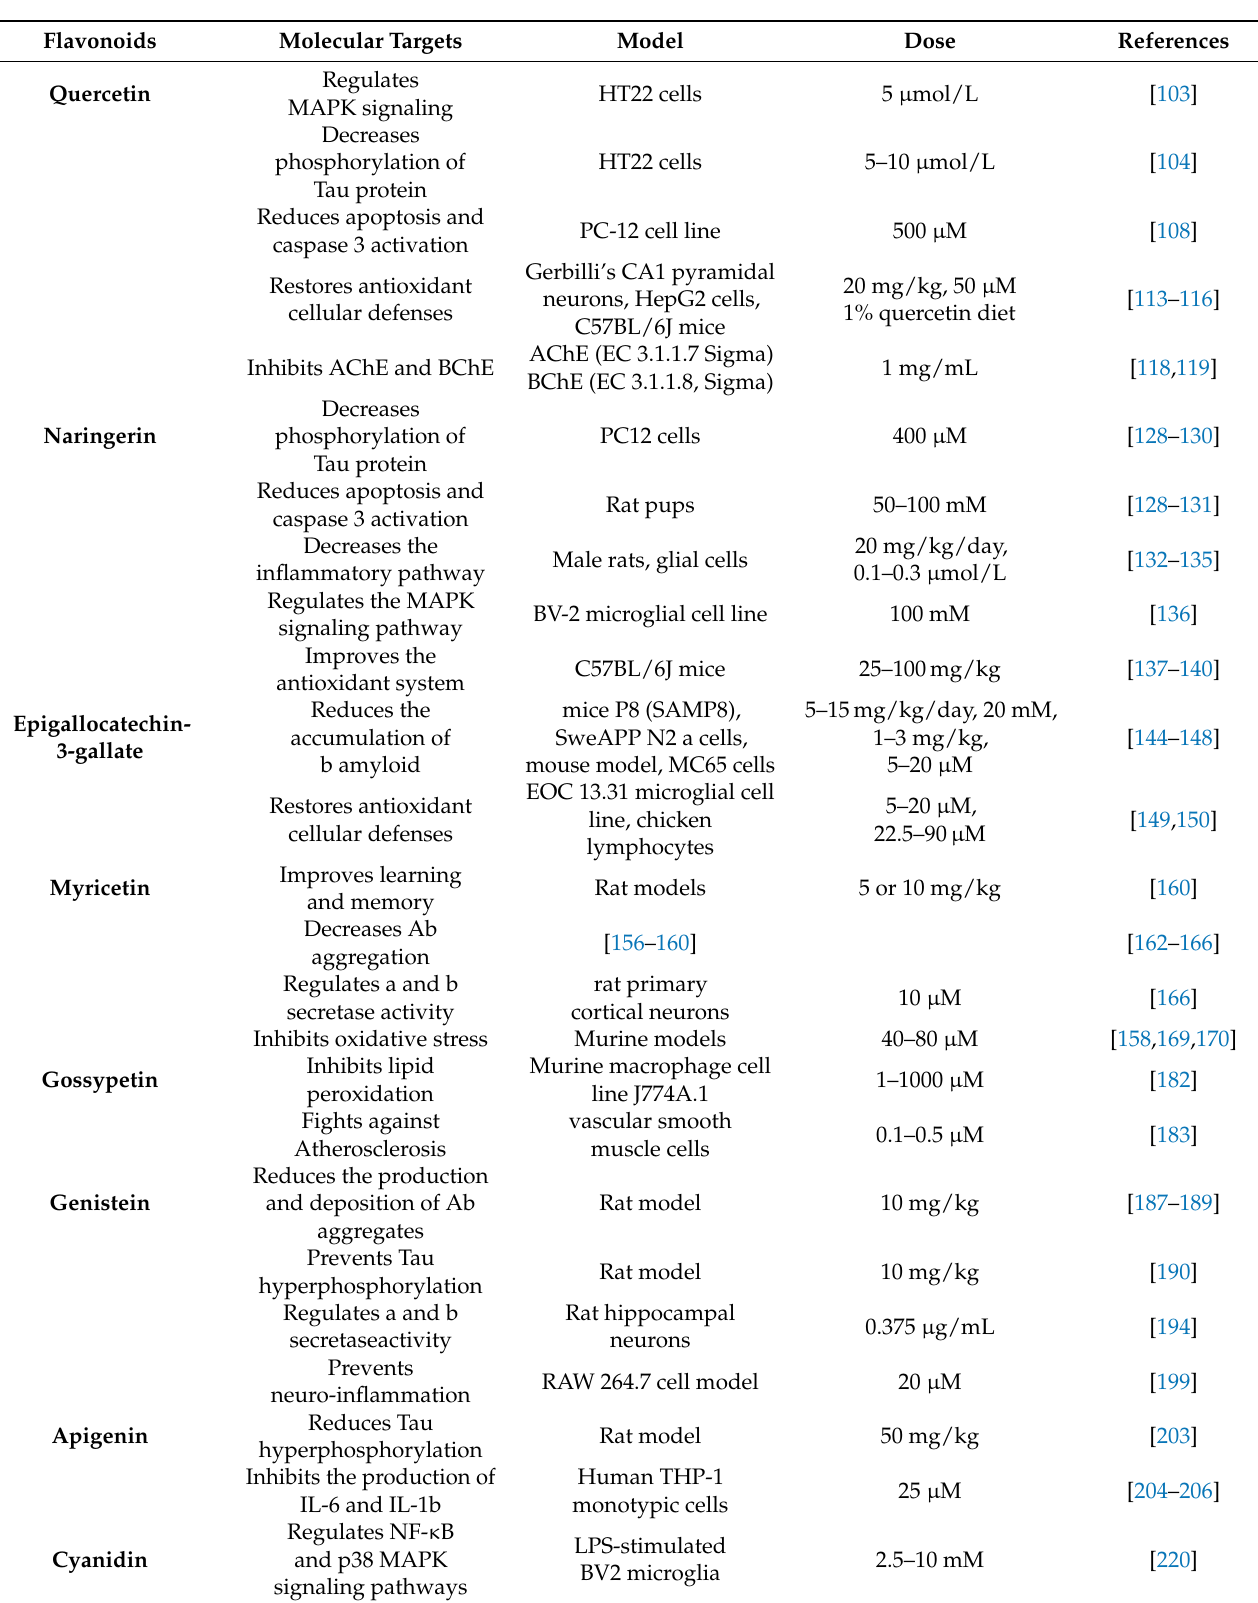
Table 1. Preclinical studies of flavonoids and their neuroprotective role against Alzheimer’s